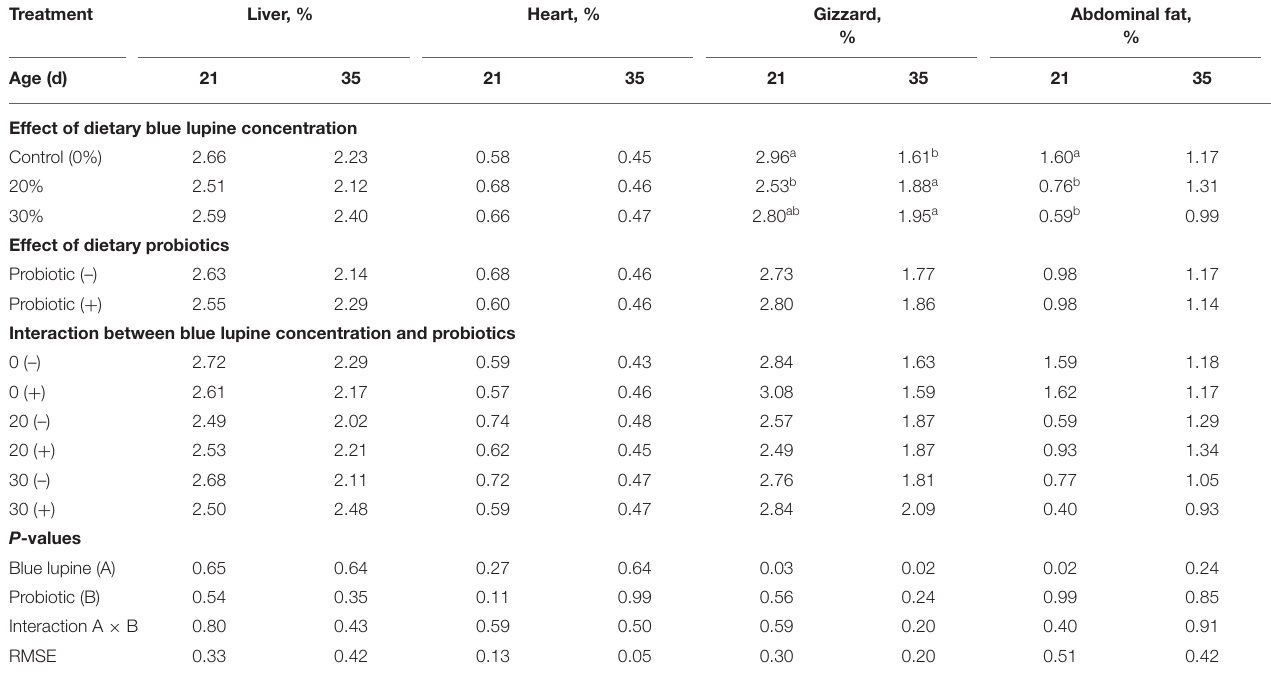
TABLE 7 | Effect of blue lupine and probiotics on internal body organs of broiler chickens at 21 and 35 d of age. Treatment Liver, % Heart, % Gizzard,